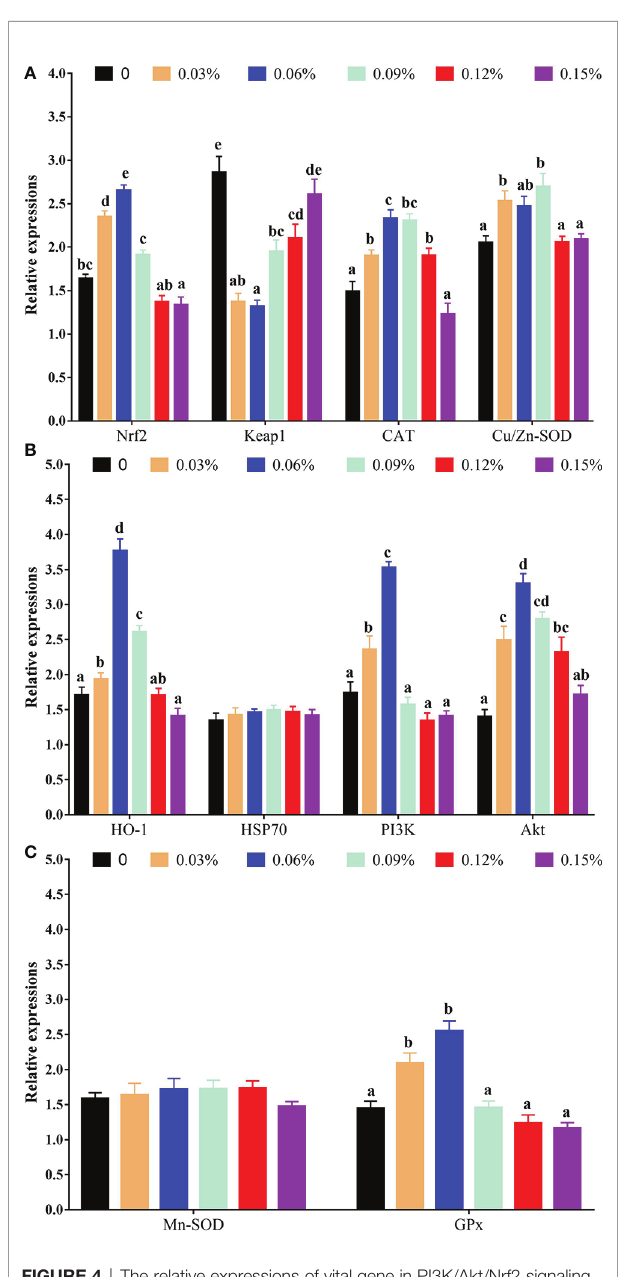
FIGURE 4 | The relative expressions of vital gene in PI3K/Akt/Nrf2 signaling pathway with different levels of TB supplementation. (A) Nrf2, Nuclear factor erythroid 2-related factor 2; Keap1, Kelch-like ECH-associated protein 1; CAT, Catalase; Cu/Zn-SOD, Copper zinc superoxide dismutase; (B) HO-1, heme oxygenase 1; HSP70, heat stress protein 70; PI3K, phosphoinositide 3- kinase; Akt, protein kinase B; (C) Mn-SOD, manganese superoxide dismutase; GPx, glutathione peroxidase. Value with different superscripts are signi fi cantly different (P <